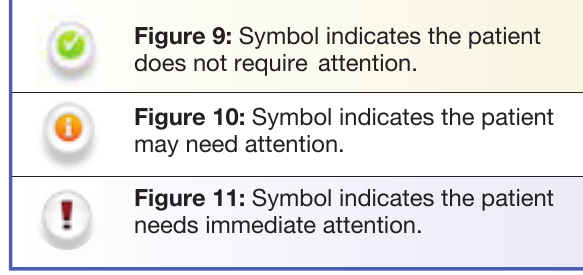
Figure 9: Symbol indicates the patient does not require attention. Figure 10: Symbol indicates the patient may need attention. Figure 11: Symbol indicates the patient needs immediate